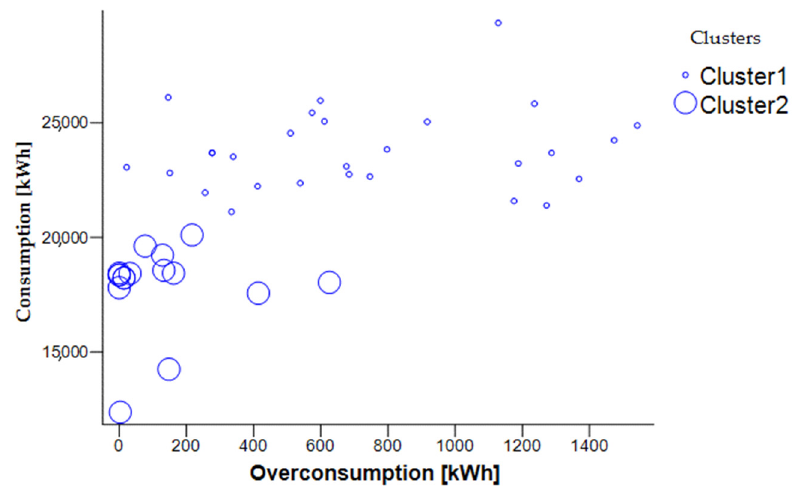
Figure 9. Graphical representation of clusters formulated from the data of the consumption and